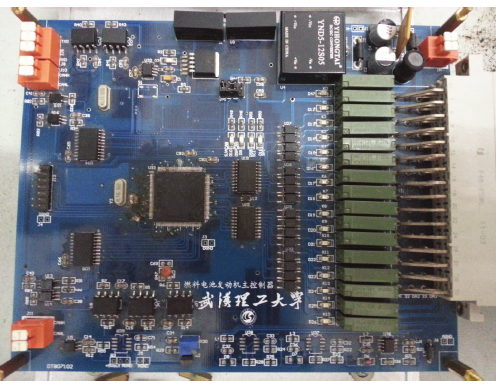
Figure 4: Control